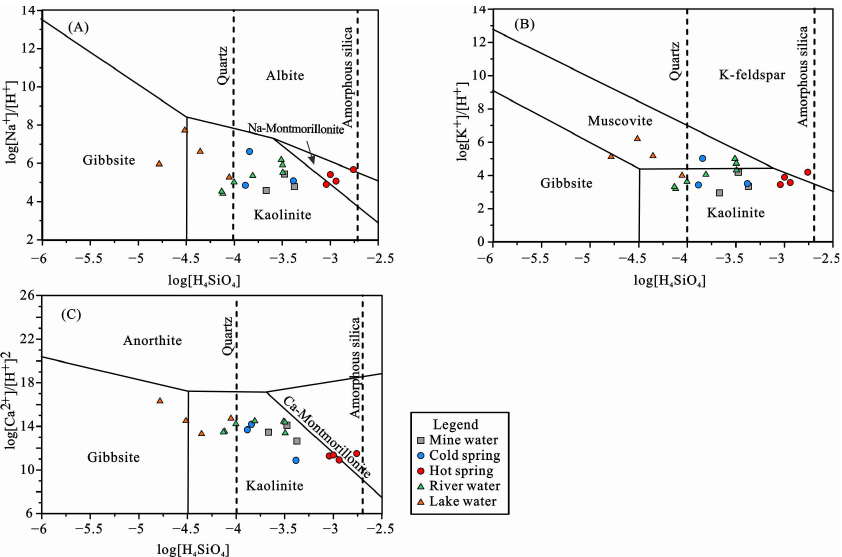
Figure 9. ( A – C ): Stability diagrams of Na ‐ , K ‐ , and Ca ‐ feldspars and their weathering products for water samples from the study area. The dashed lines represent saturation with respect to quartz and amorphous silica.